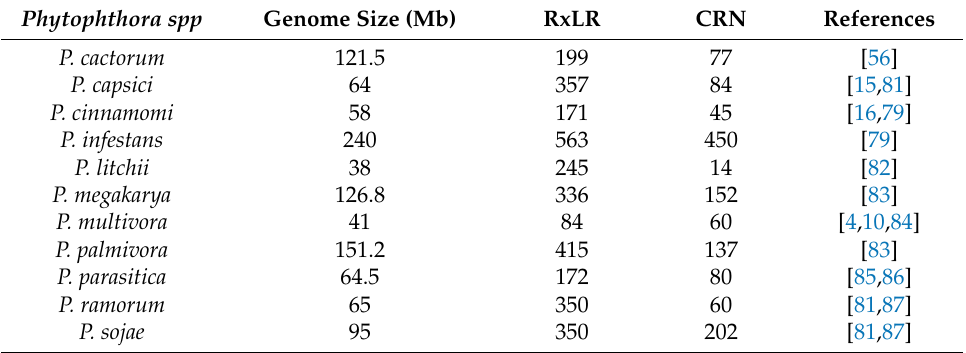
Table 3. Predicted number of RxLR and CRN e ff ectors in Phytophthora species. Phytophthora spp Genome Size